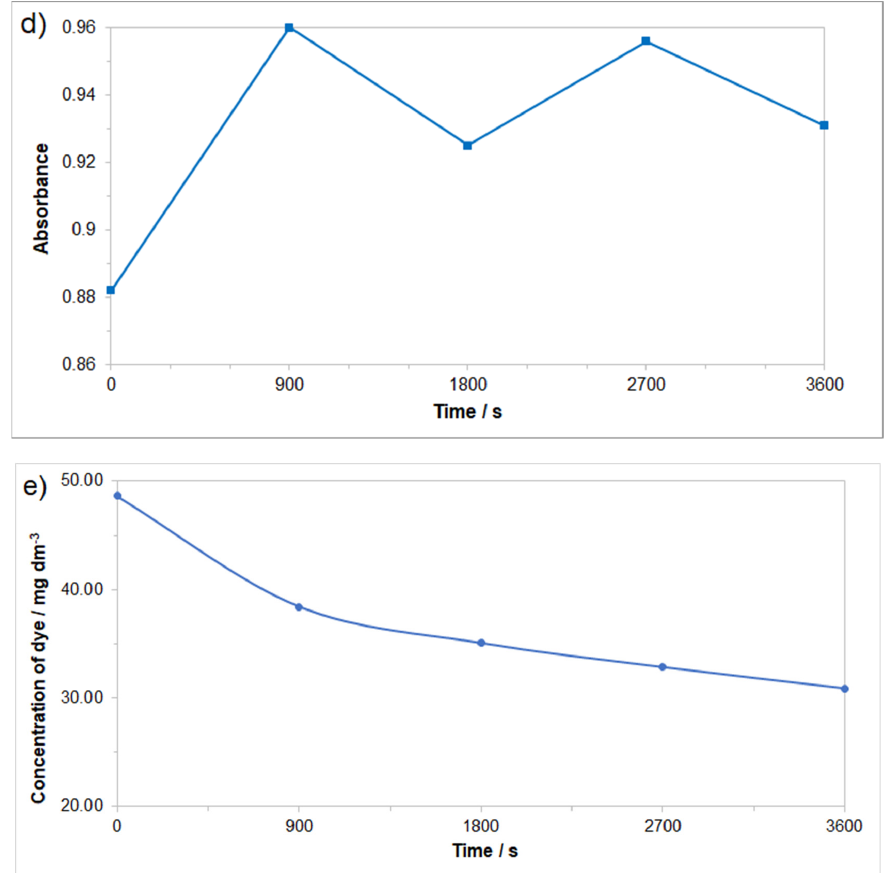
Figure 6. UV-Vis absorption spectra changes in time for AM dye’s electrodegradation, carried-out by means of Cu/Fe galvanic cell, where: ( a ) Representation of the three segments of AM dye’s electrooxidation process on the surface of Fe anode in Na 2 SO 4 solution (for an initial dye concentration of 50 mg dm − 3 ); ( b ) evolution of decolorization process, recorded for a wavelength of 500 nm; ( c ) progress of aromatic ring degradation, recorded for a wavelength of 280 nm; ( d ) evolution of mineralization process, recorded for a wavelength of 240 nm; ( e ) quantitative dye assay after sedimentation process, recorded for a wavelength of 500 nm.